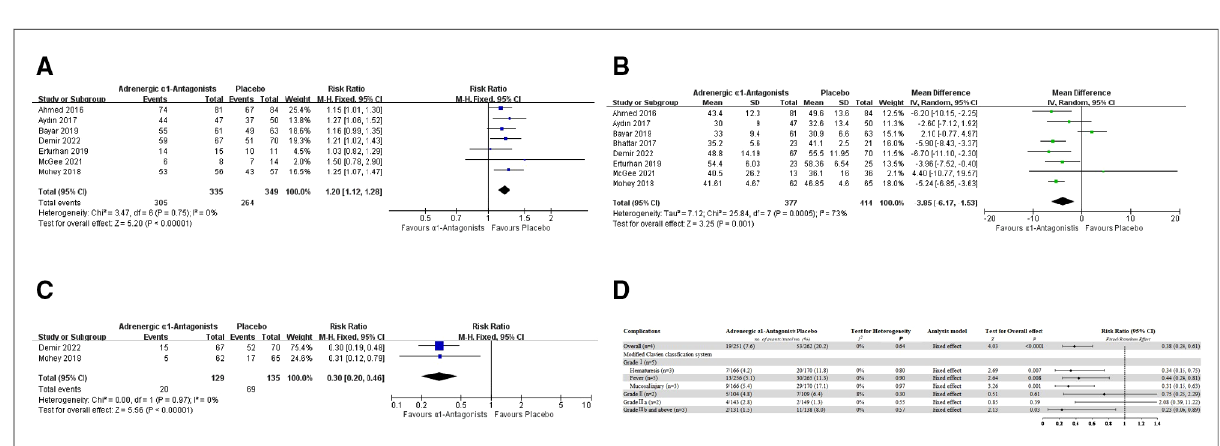
FIGURE 3 ( A ) Forest plot for 4th week stone free rate. ( B ) Forest plot for operation time. ( C ) Forest plot for postoperative analgesia. ( D ) Forest plot for postoperative